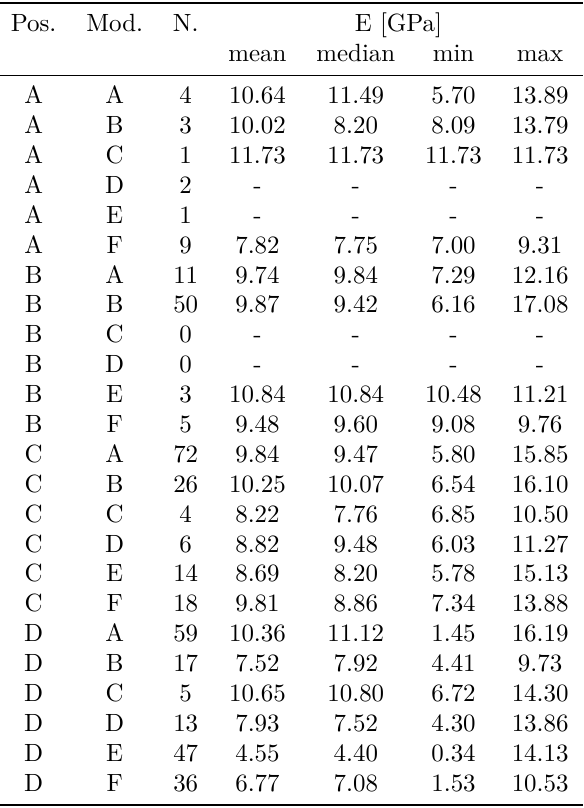
Table 6. Young’s moduli from tensile test for com- bining positions of failure cracks and corresponding failure modes.